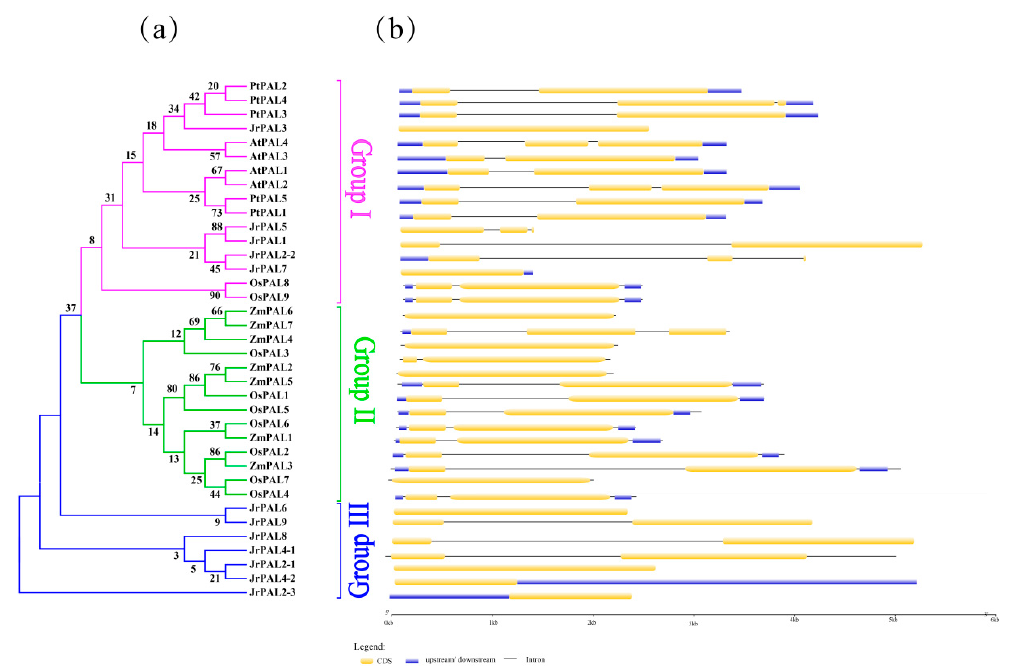
Figure 4. ( a ) Phylogenetic relationships and ( b ) gene structures of PAL genes in Arabidopsis , poplar, rice, maize, and common walnut. CDS, upstream/downstream, introns, and intron insertion are shown. Orange boxes indicate coding sequence, blue boxes indicate upstreams or downstreams genes, and gray lines represent introns.